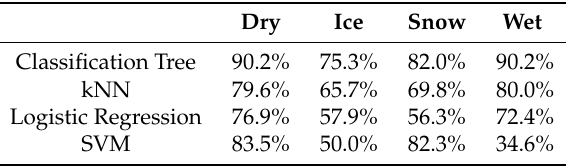
Table 4. Comparison of machine learning algorithms in terms of